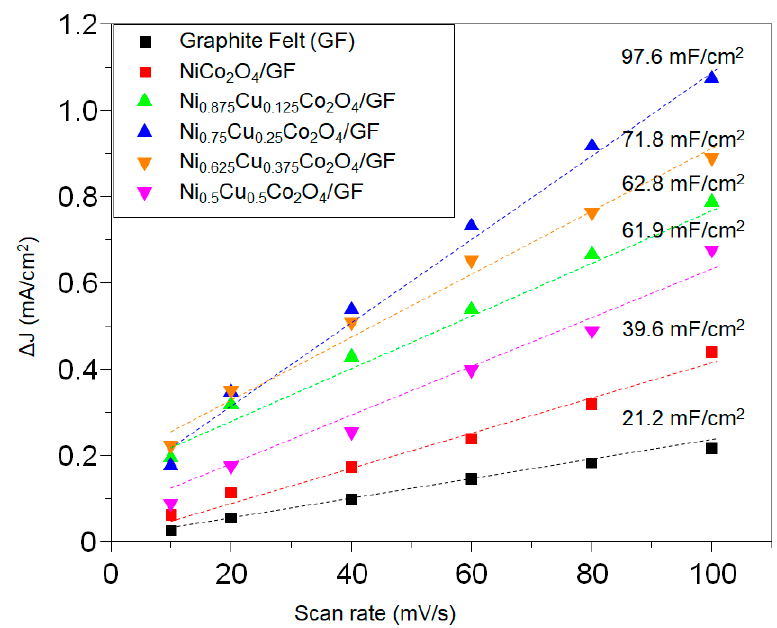
Figure 5. Current density di ff erences depending on scan rate for all electrodes.